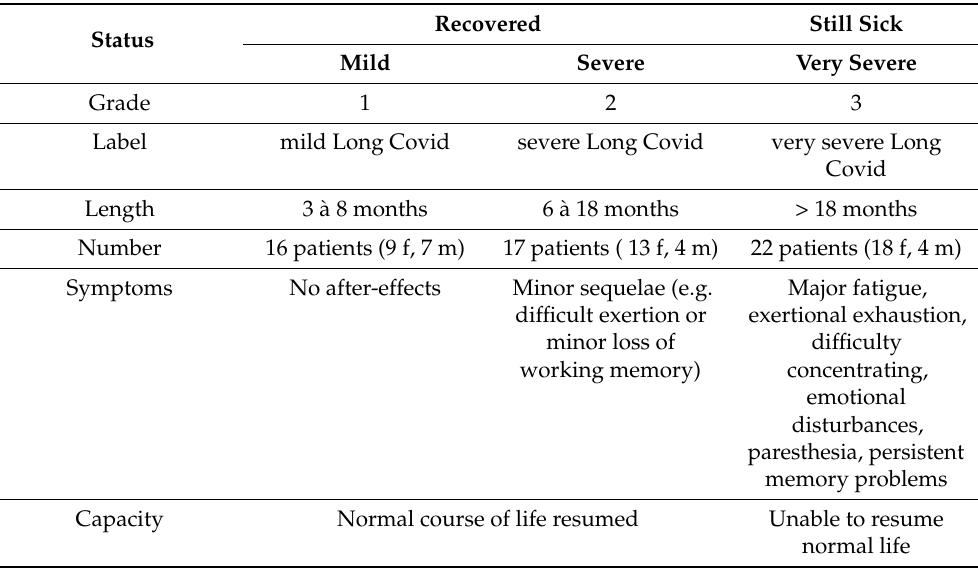
Table 1. Evolution over time of a cohort of patients seen in family medicine with PACS after an acute COVID-19 episode (Centre médical Janson, Charleroi, Belgium, 2021–2022).